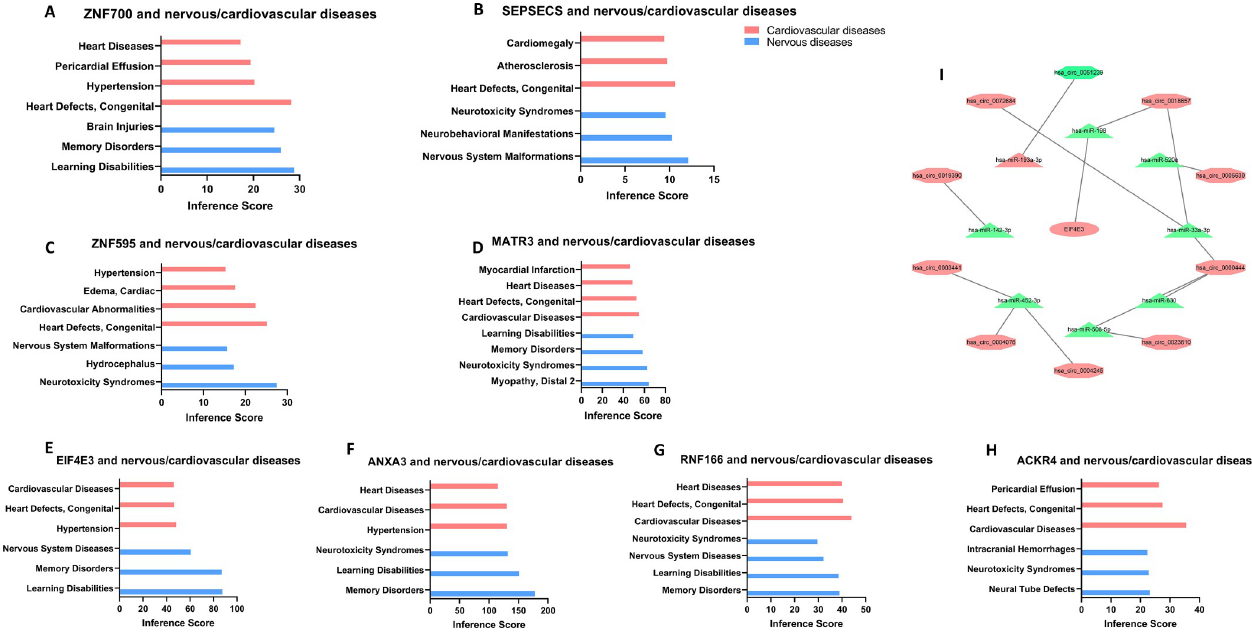
Fig 8. Nervous and cardiovascular diseases related to hub genes based on the CTD database (A-H), circRNA-miRNA-mRNA network (I).